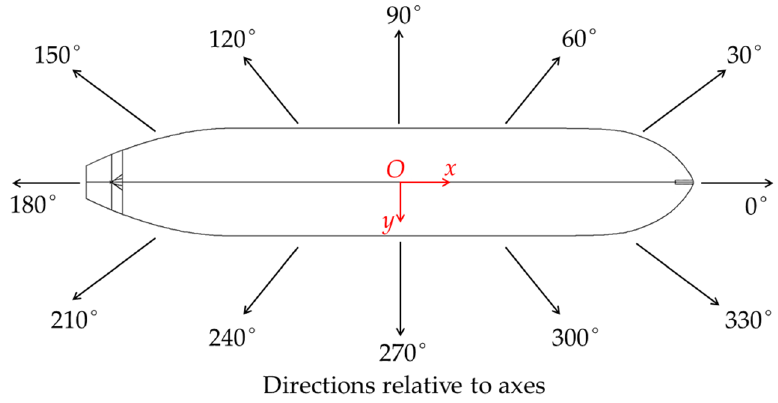
Figure 3. The wave